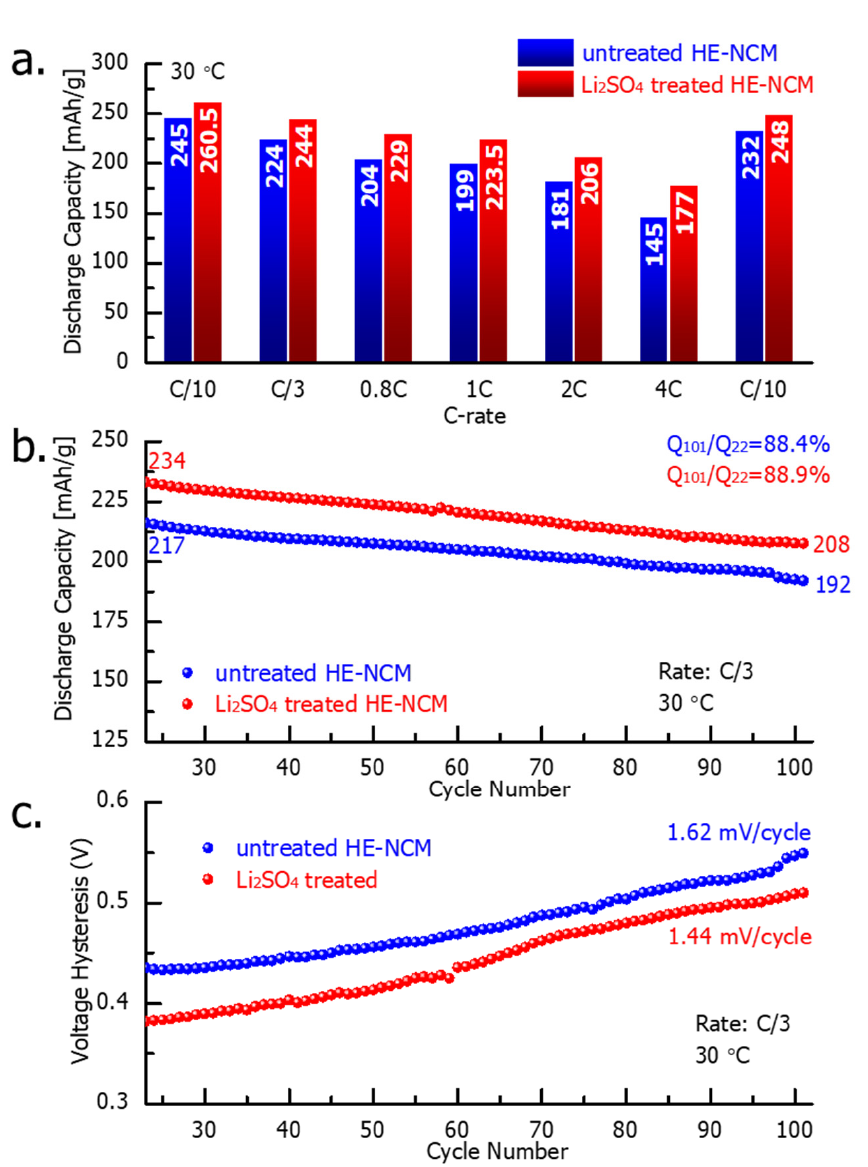
Figure 6. Results of the electrochemical studies of HE-NCM electrodes comprising untreated and Li 2 SO 4 -treated HE-NCM materials, as indicated: ( a ) discharge capacity obtained at various current densities (C-rates); ( b ) prolonged cycling, and ( c ) the voltage hysteresis. Experiments were performed in coin-type cells with Li counter-electrodes, LP-57 solution, at 30 ◦ C. Note that each experiment in this study was carried out for at least 2–3 cells simultaneously, and the results were aver- aged.